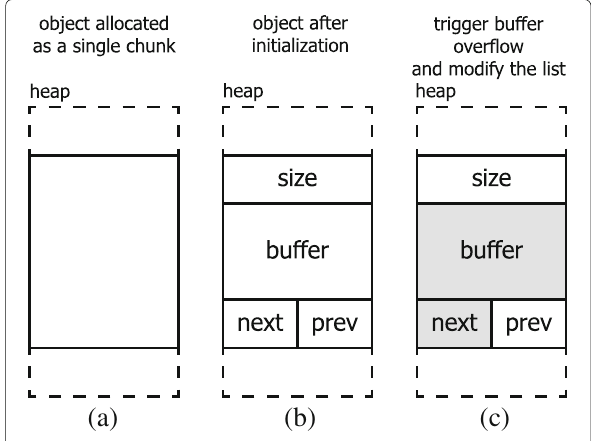
Fig. 2 An example of fine-grained memory access error. buffer overflows next inside the same memory chunk